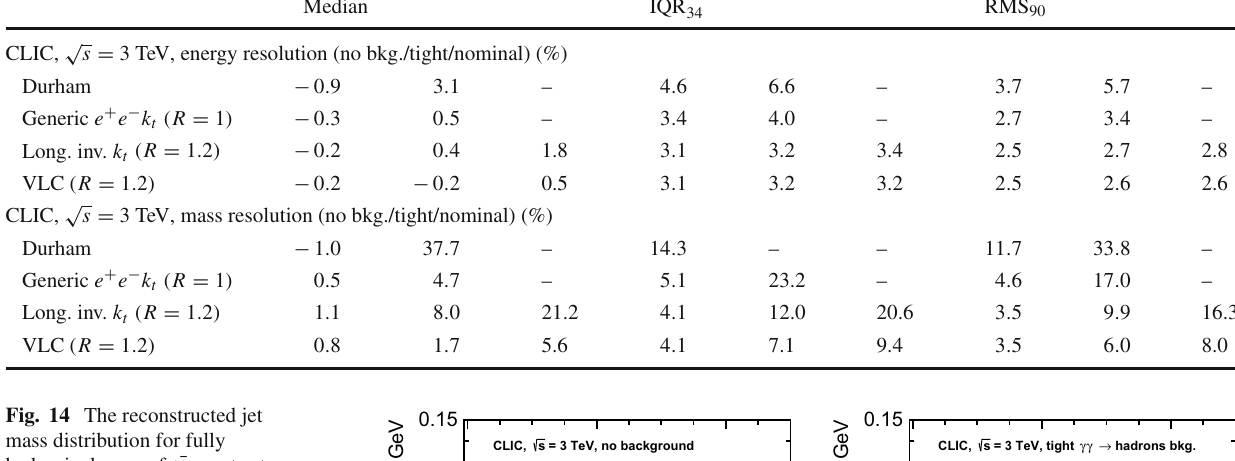
Fig. 14 The reconstructed jet mass distribution for fully hadronic decays of t ¯ t events at a 3 TeV CLIC. No backgrounds are added in the left plot. In the right plot 60 bunch crossings of γγ → hadrons background are overlaid on the signal and particle-flow objects are selected using the tight